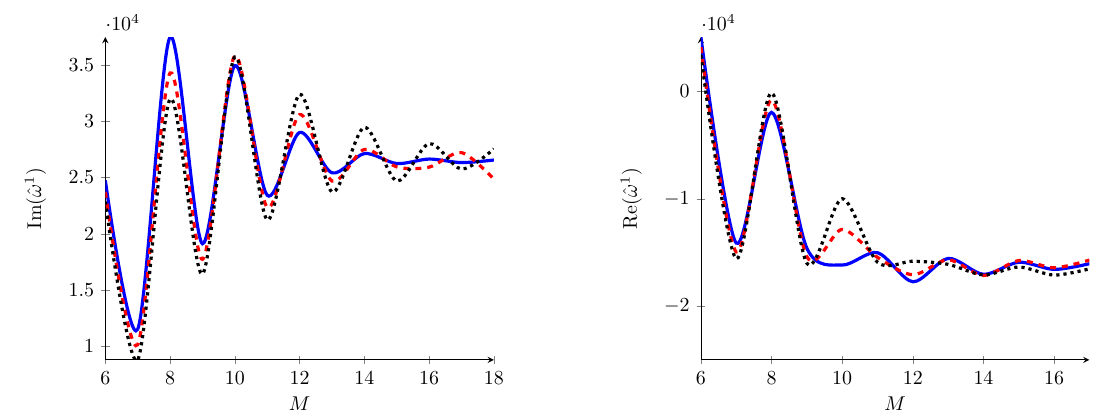
Figure 5 . The convergence of the real and imaginary part of the correction ^ ! 1 for b = 5 (cid:12)rst tensor QNM computed for various grid sizes M (shown in a smoothed plot) and for di(cid:11)erent interval sizes. The solid blue line corresponds to [ l; k ] = [0 : 1 ; 0 : 99], the dashed red line corresponds to [ l; k ] = [0 : 11 ; 0 : 98] and the dotted black line corresponds to [ l; k ] = [0 : 12 ; 0 :